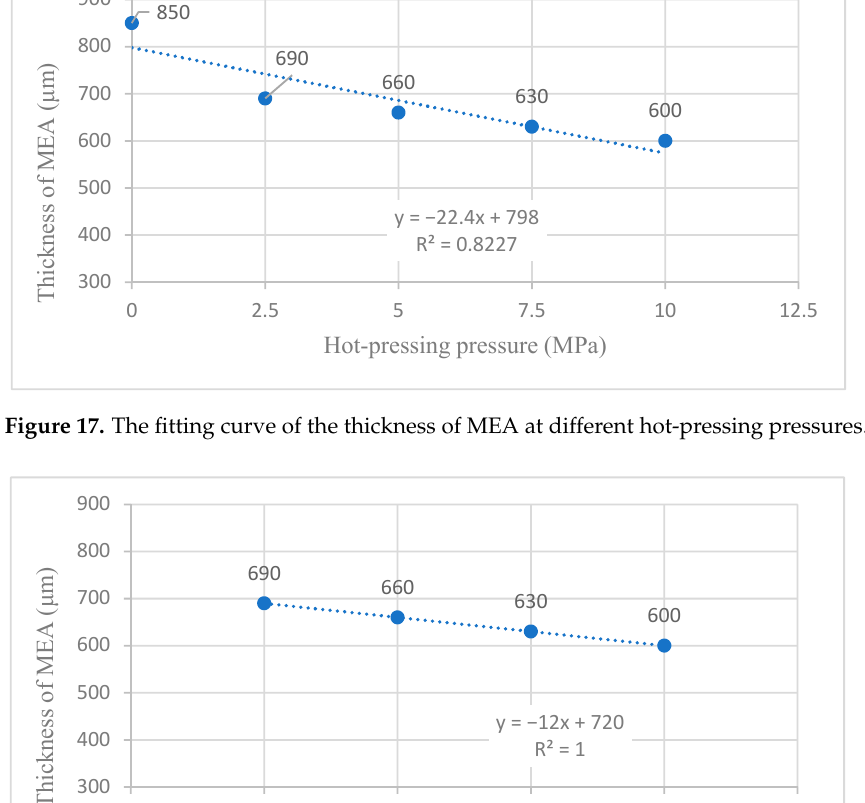
Figure 16. The effect of hot-pressing temperature on the performance of titanium mesh-based MEA at 60 °C with an oxygen environment. ( a ) Curve between current density and voltage; ( b ) curve between current density and power density.